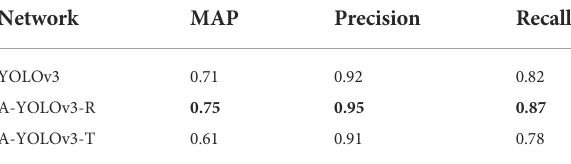
TABLE 2 Metrics of different networks.